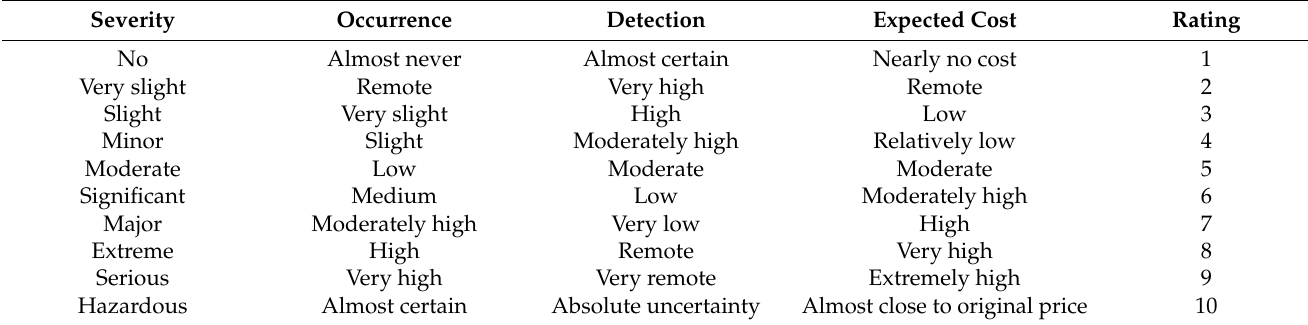
Table 1. Corresponding ratings of linguistic